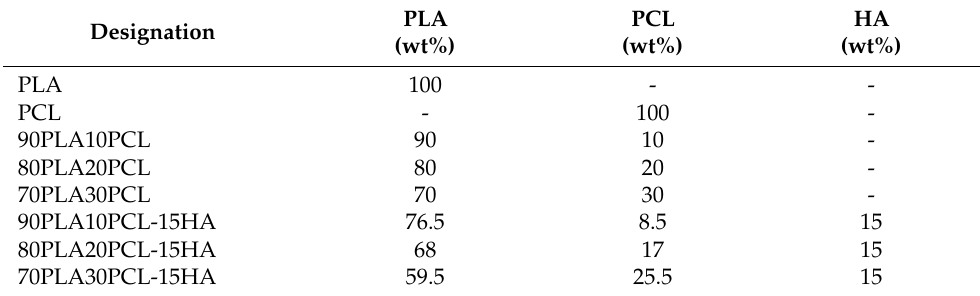
Table 1. Composition of blends and composites describing the amount of polylactic acid (PLA), polycaprolactone (PCL) and hydroxyapatite (HA) in wt%. The designations of the composite samples containing HA were chosen to facilitate the comparison with the samples without HA, as the ratios between PLA and PCL were maintained at 90:10, 80:20 and